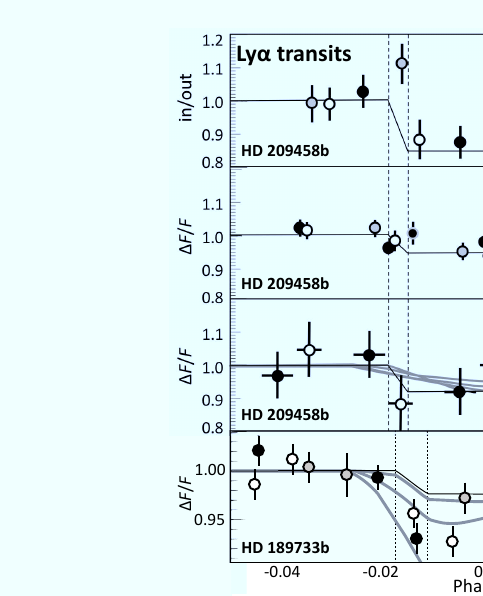
Figure 1: Lyman- α transit light curves obtained for HD 209458b ((a)Vidal-Madjar et al. 2003, (b) Vidal-Madjar et al. 2004, and (c) Ehrenreich et al. 2008) at different resolutions and HD 189733b ((d) Lecavelier des Etangs et al. 2010). Different colors indicate different transits. Gray curves are model light curves produced by particle simulations of the atmospheric